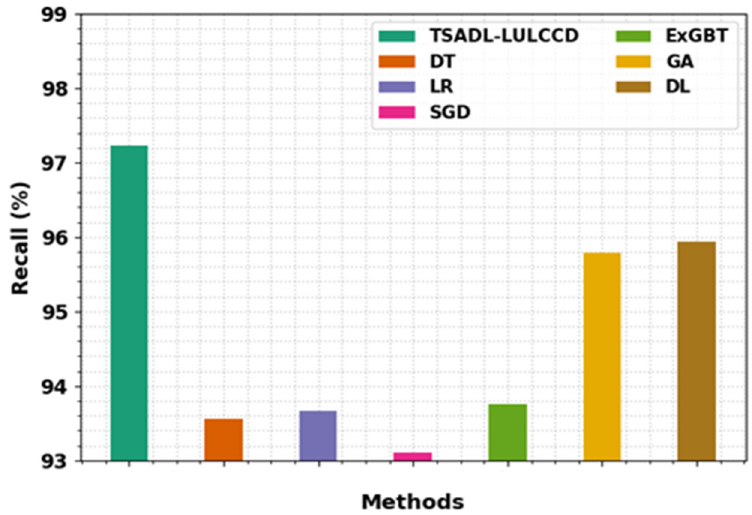
Figure 17. Reca l analysis of TSADL-LULCCD approach with other approaches. Figure 17. 𝑅𝑒𝑐𝑎 (cid:3039) analysis of TSADL-LULCCD approach with other approaches. Figure 18 denotes 𝐹 (cid:3046)(cid:3030)(cid:3042)(cid:3045)(cid:3032) investigation of the TSADL-LULCCD model with recent